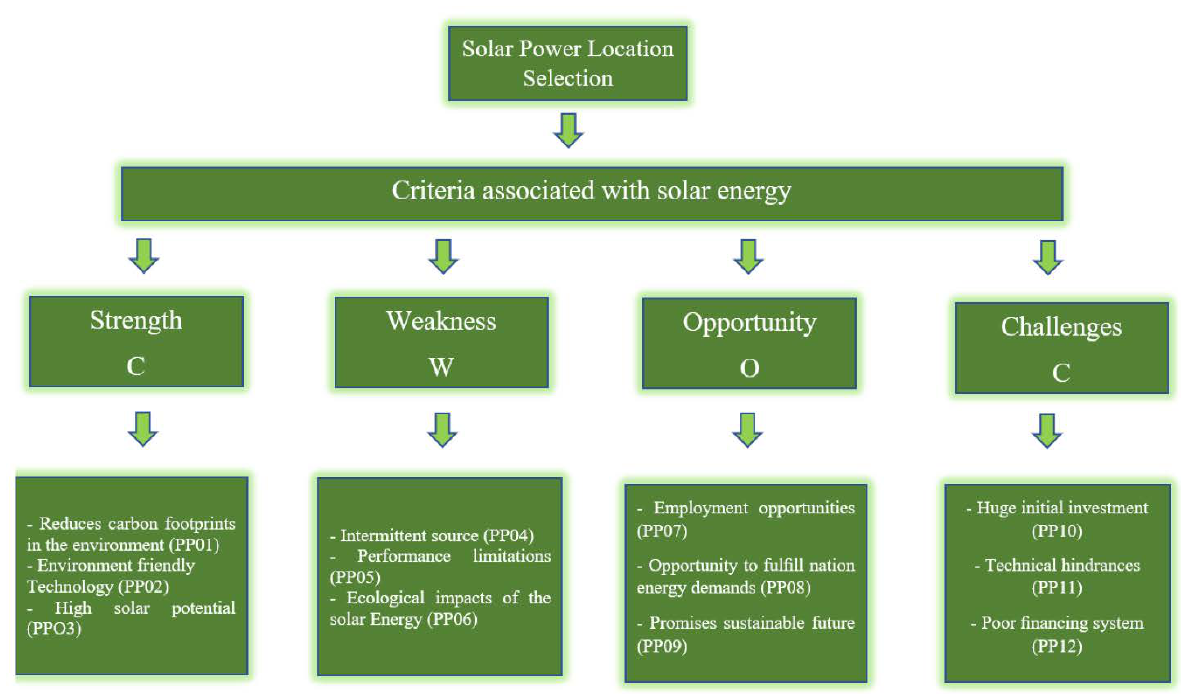
Figure 2. Fuzzy AHP structure of the study.